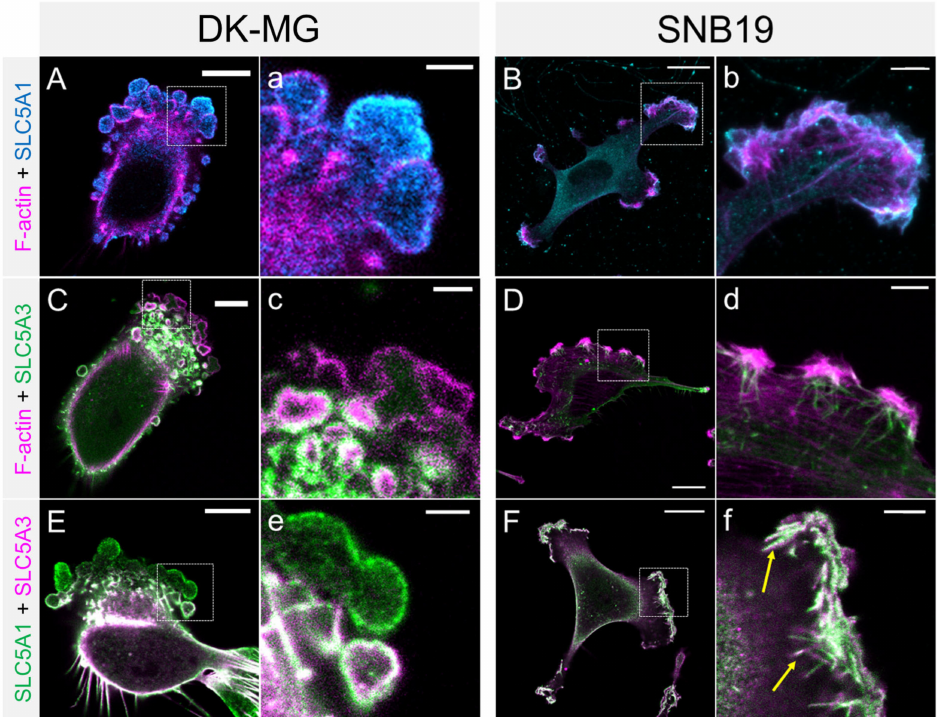
Figure 5. Confocal fluorescence images of DK-MG and SNB19 cells co-stained for F-actin and SLC5A1 ( A , B ), F-actin and SLC5A3 ( C , D ) or SLC5A1 and SLC5A3 ( E , F ). Co-localization of SLC5A1 and SLC5A3 is depicted in white. SLC5A1 predominantly localized to the cell compartments involved in migration, i.e., lamellipodia ( B – F ) and blebs ( A , C , E ). Lowercase letters show magnifications of the boxed regions in ( A – F ). Both transporter proteins display colocalization in lamellipodial tips of SNB19 cells (arrows in f ). Scale bars: 15 µ m in ( B – F ), 10 µ m in ( A , C , E ), 5 µ m in ( d ), 2.5 µ m in ( a – c , e , f